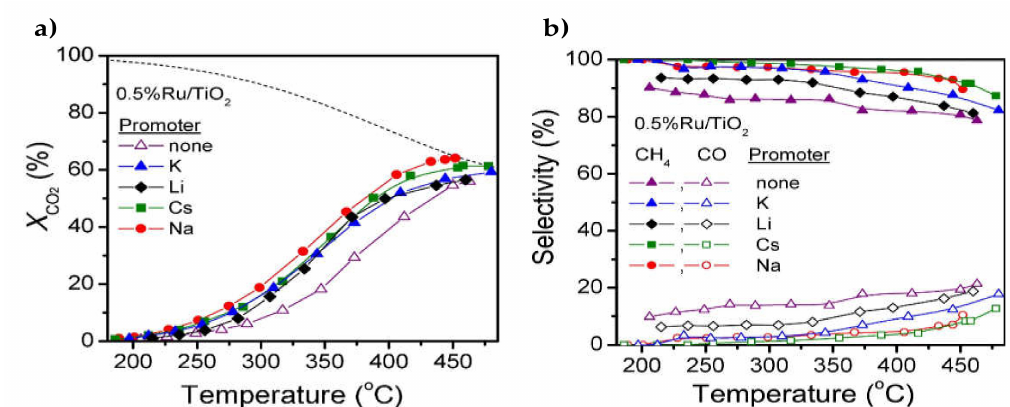
Figure 1. ( a ) Conversions of CO 2 and ( b ) selectivity toward CH 4 and CO as a function of reaction Table 0. Ru / X-TiO 2 catalysts of the same alkali loading (0.2 wt.%). Experimental conditions: mass of catalyst: 100 mg; particle diameter: 0.18 < d p < 0.25 mm; feed composition: 5% CO 2 , 20% H 2 (balance He); total flow rate: 150 cm 3 min − 1 . Reproduced with permission from ref. [33]. Copyright 2018